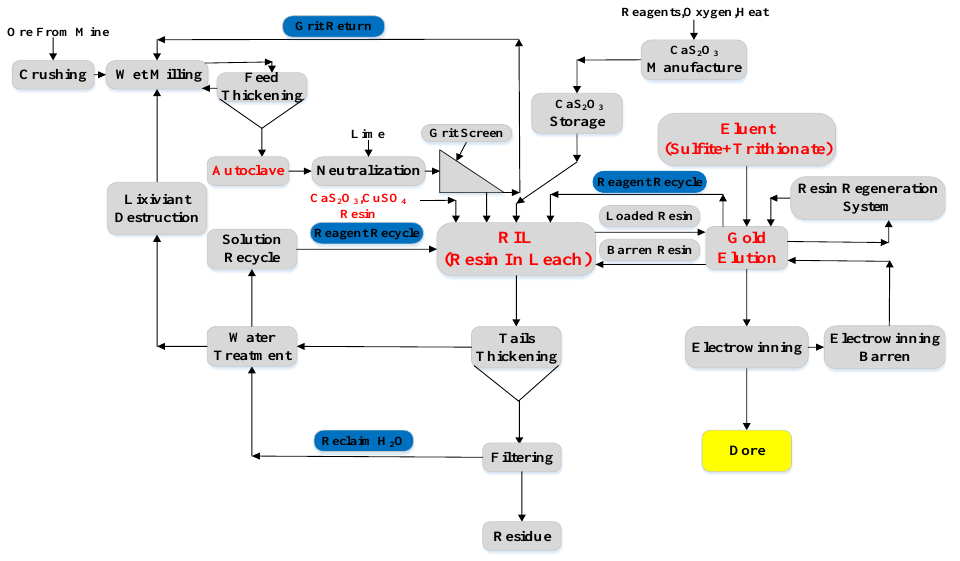
Figure 1. Ammonia-free thiosulfate leaching process by Barrick Gold Corporation to treat a carbon-bearing sulfide gold ore pretreated with acidic or alkaline pressure oxidation [4,5]. Table 1. Evaluation of various gold recovery techniques from pregnant thiosulfate solutions.